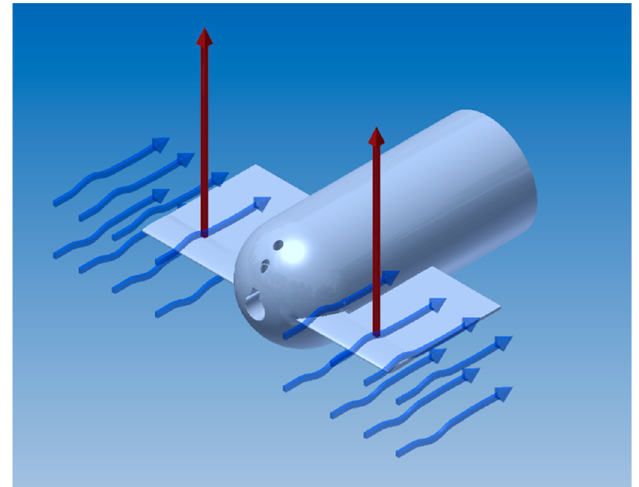
Figure 9. Foil attached to the head piece.